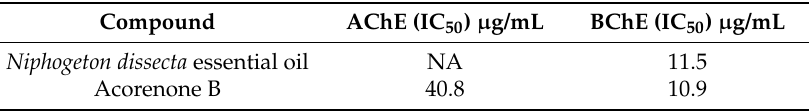
Table 4. Cholinesterase inhibitory activity.